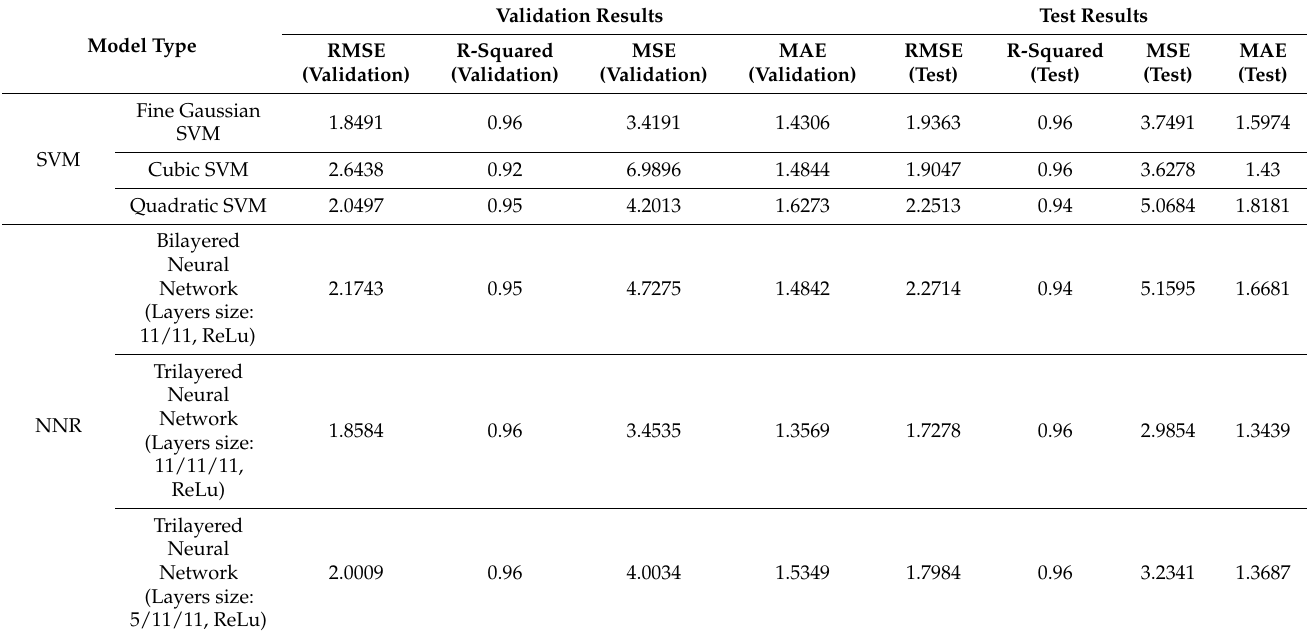
Table 3. Prediction errors of SVM, NNR, GPR models.